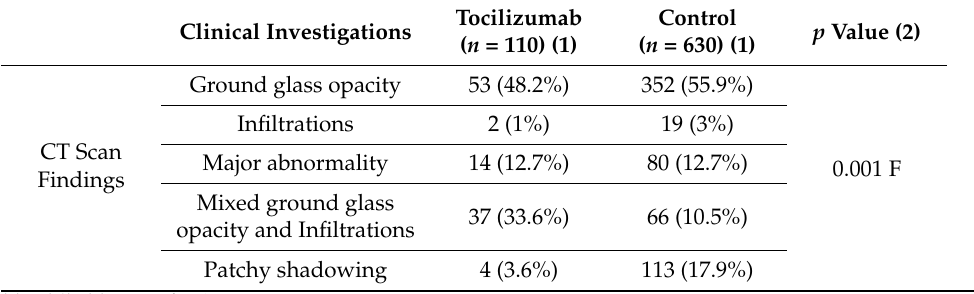
Table 4. Clinical investigations at hospital admission of the study